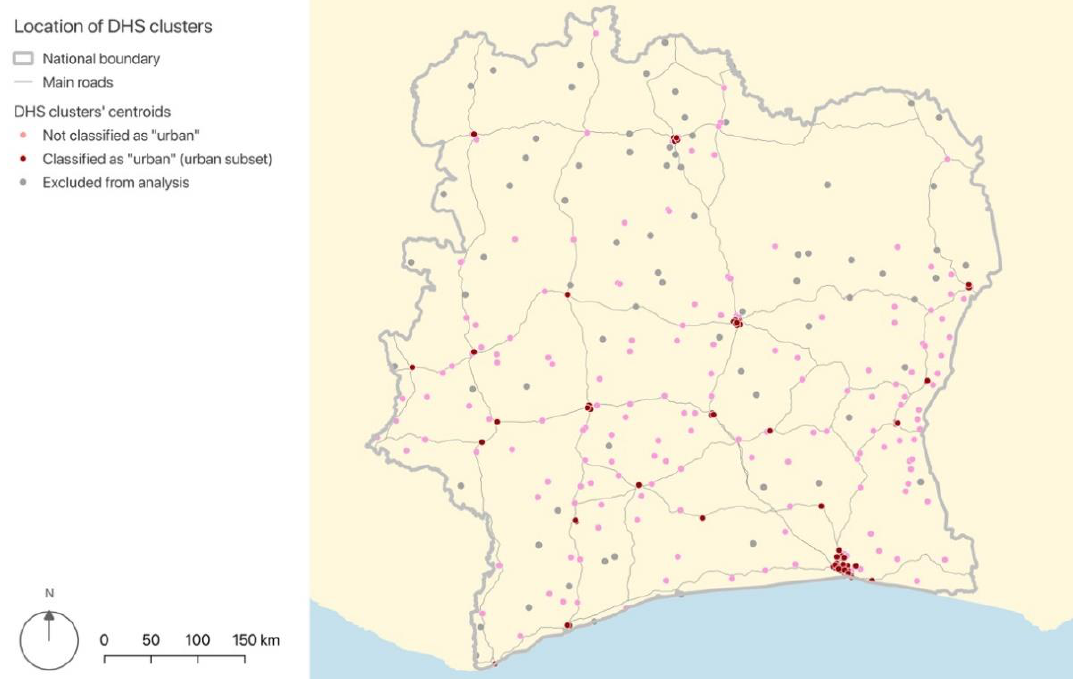
Figure 4. Location of DHS clusters, by subset. Elaborated by the authors with QGIS, from: DHS [28], GADM and OpenStreetMap.